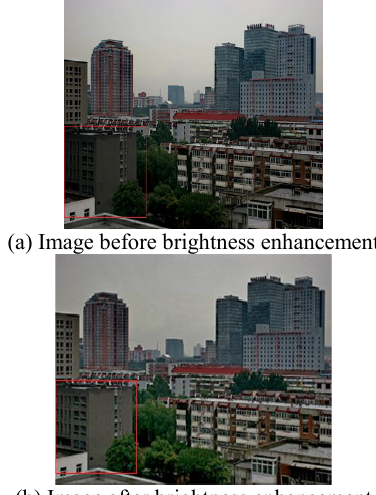
Figure 2. Gamma function processing result